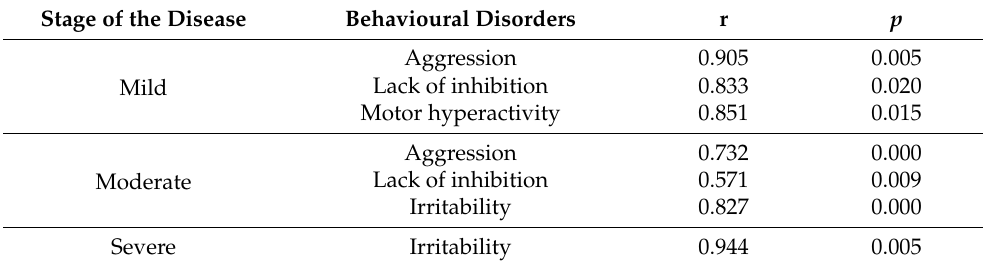
Table 12. Correlations between Abuse, behavioural disorders and stage of the disease. Stage of the